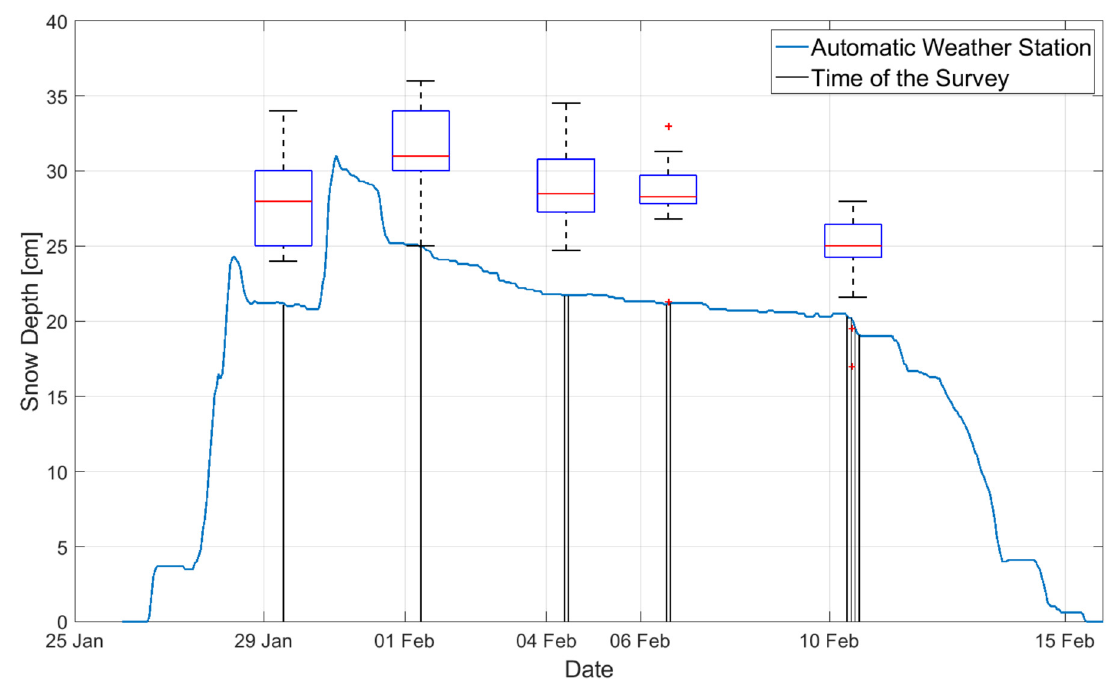
Figure 2. Accumulated snow depth measured at the Daegwallyeong AWS station, which is 2 km away from the study site. Times of survey are shown as vertical lines. In situ measurements for each surveying day are expressed as box